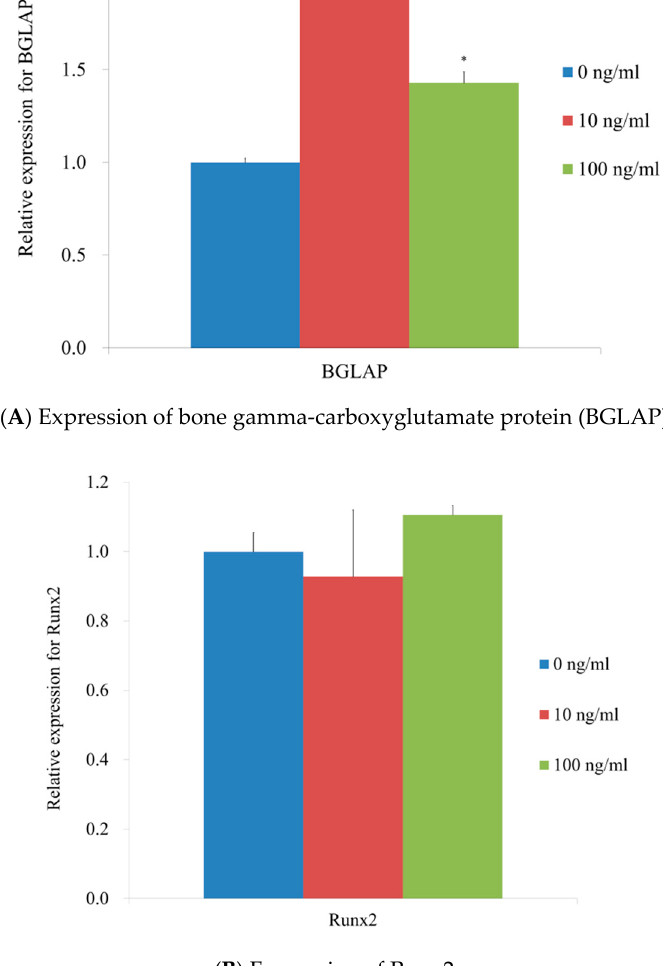
Figure 7. Quantification by real-time polymerase chain reaction. * Statistically significant increase was seen when compared with 0 ng/mL at Day 7 ( p < 0.05).